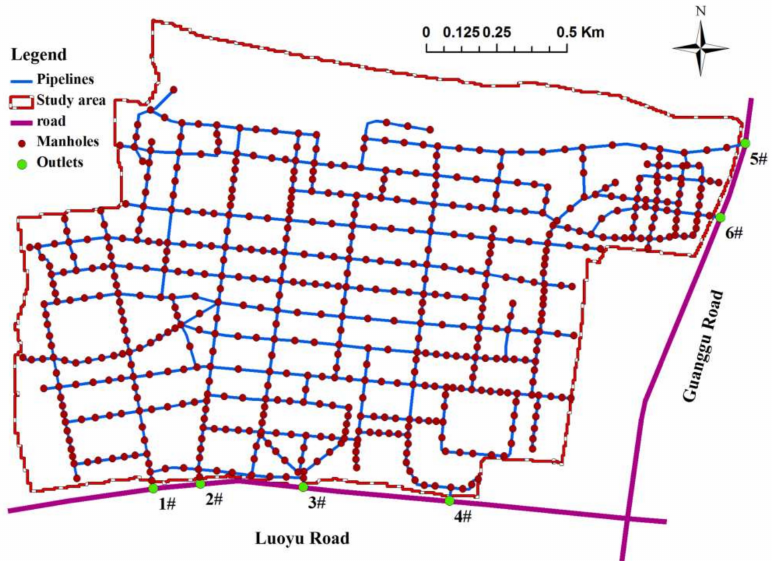
Figure 8. Geospatial and geometric information of the storm sewer system in the study